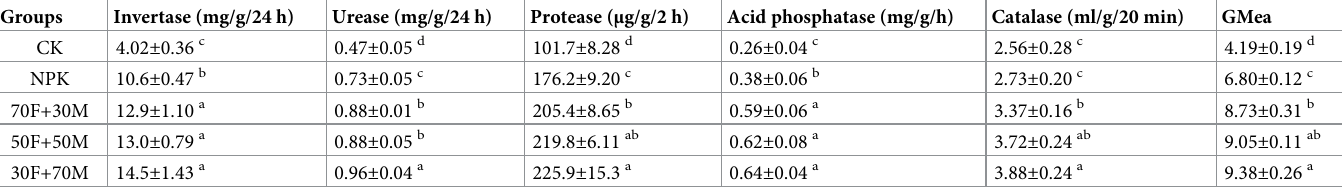
CK: non-fertilization group; NPK: balanced inorganic fertilization; 70F+30M: 70% chemical and 30% organic fertilizer group; 50F+50M: 50% chemical and 50% organic fertilizer group; 30F+70M: 30% chemical and 70% organic fertilizer group; GMea: Geometric mean of enzyme activities. For all variables with the same letter, the difference between the means is not statistically significant ( p > 0.05). If two variables have different letters, they are significantly different ( p < 0.05).